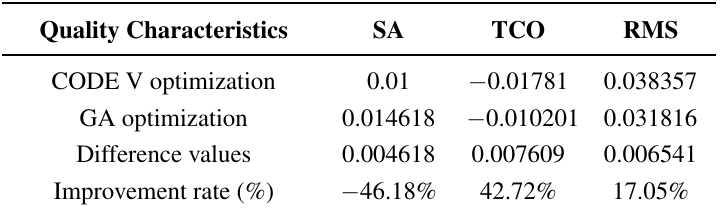
Table 13. Comparisons of third-order aberrations of the CODE V built-in and proposed optimization methods for 550 degrees myopia and 175 degrees astigmatism for pupil size 6 mm.